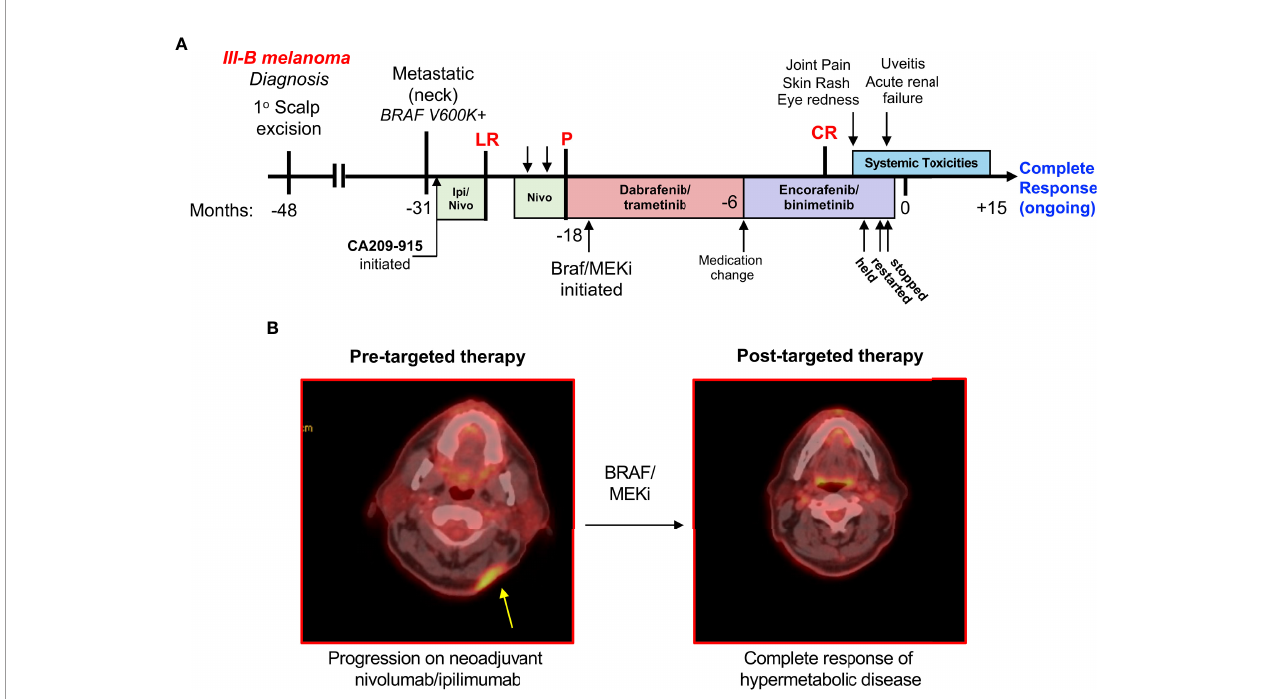
FIGURE 1 | Timeline of therapy and toxicity in a patient who experienced a complete response to BRAF/MEKi. (A) A patient whose BRAF V600K+ metastatic melanoma was unresponsive to combination ipilimumab/nivolumab and nivolumab monotherapy eventually responded well to BRAF/MEKi. This patient was treated with dabrafenib/trametinib for a year, followed by 6 months of encorafenib/binimetinib. After this time, the patient experienced signi fi cant multi-organ toxicities. LR, local recurrence; P, progression; CR, complete response. (B) ( left ) Positron emission tomography depicting recurrence within scar after multiple resections of in- transit metastasis and adjuvant nivolumab-ipilimumab. ( right ) Complete response of all hypermetabolic disease after treatment with BRAF-MEK inhibitors which developed approximately 3 months prior to the onset of toxicities